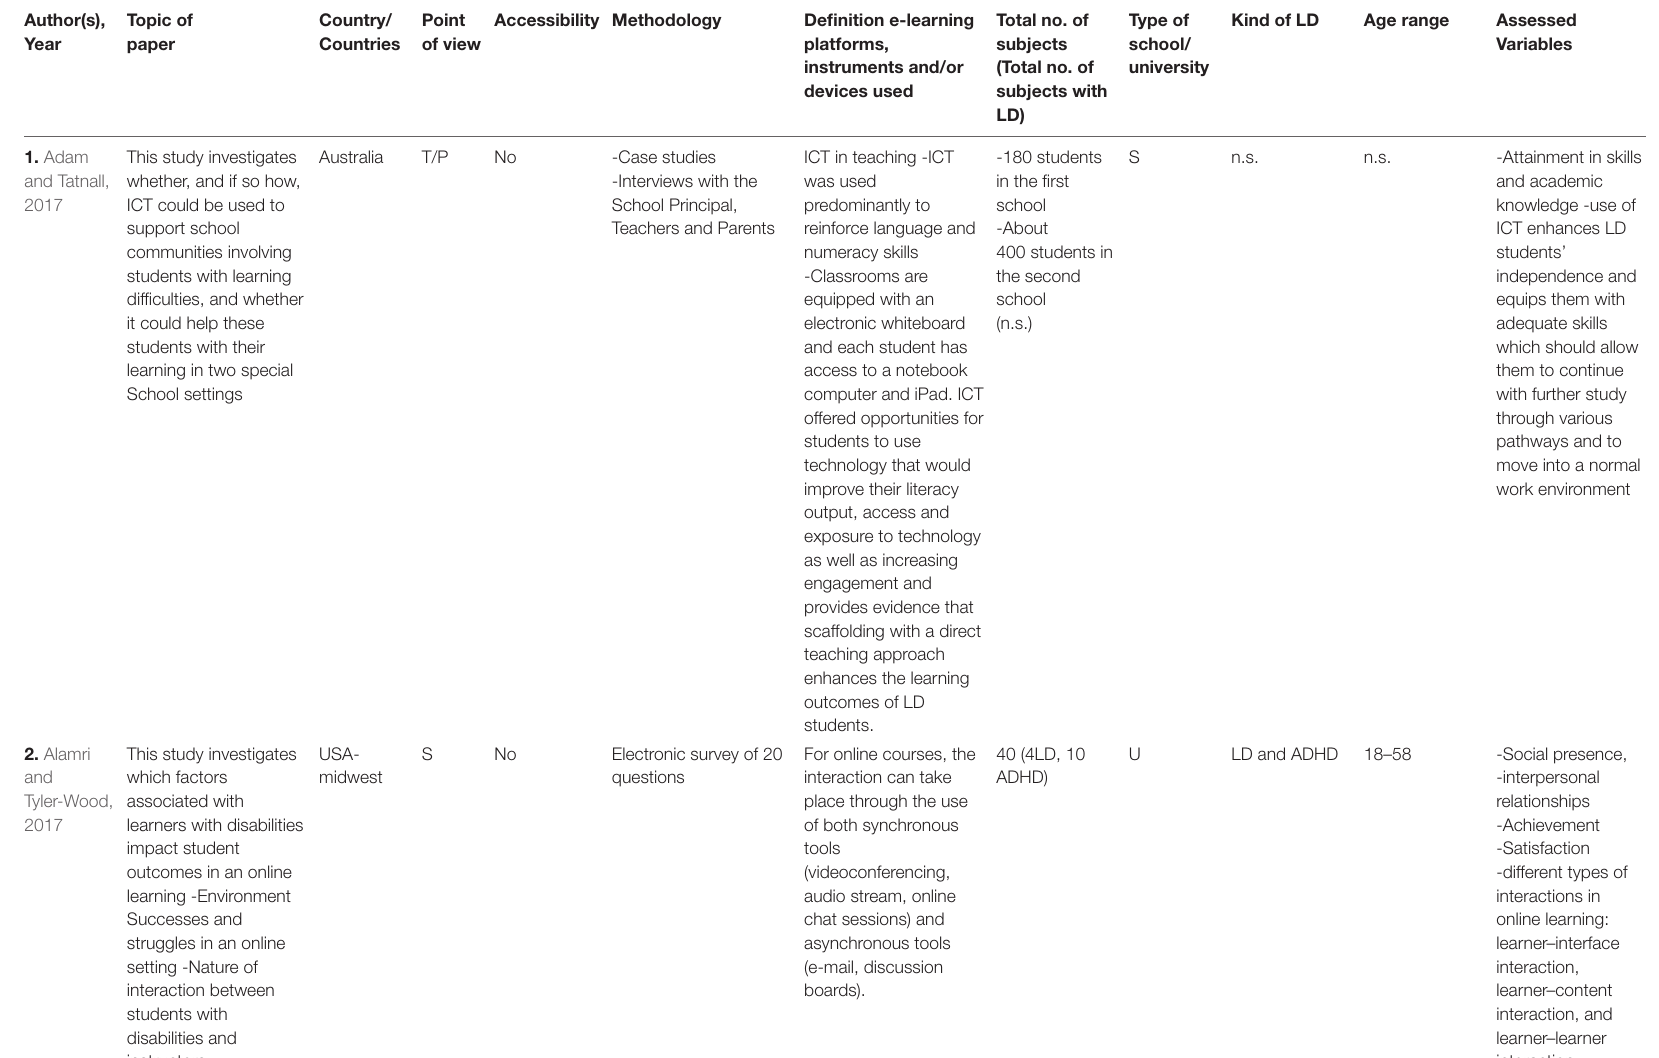
TABLE 1 | Characteristics of papers which met the inclusion